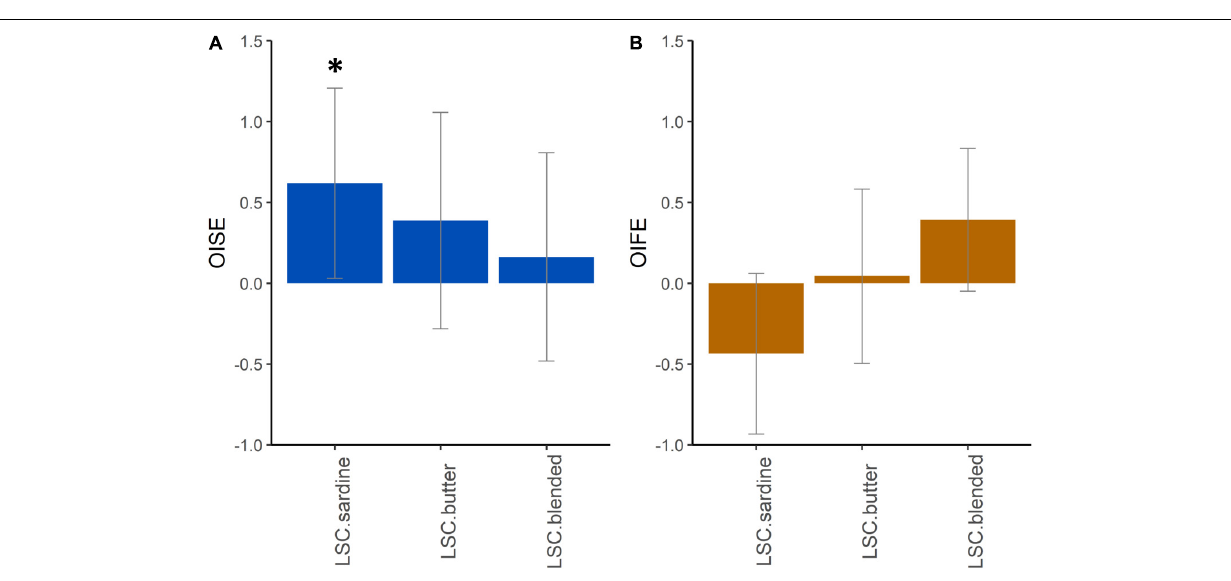
only fat perception but also salty taste perception (32).